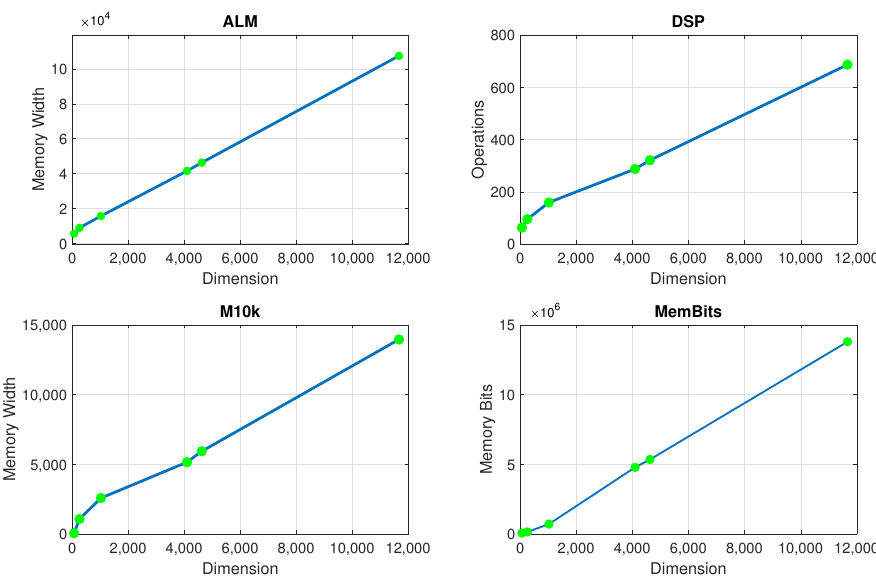
Figure 12. FPGA hardware resource use for the AM-AM PA model with RT implementation (in terms of, ALM, DSP, M10K, and Memory Bits).